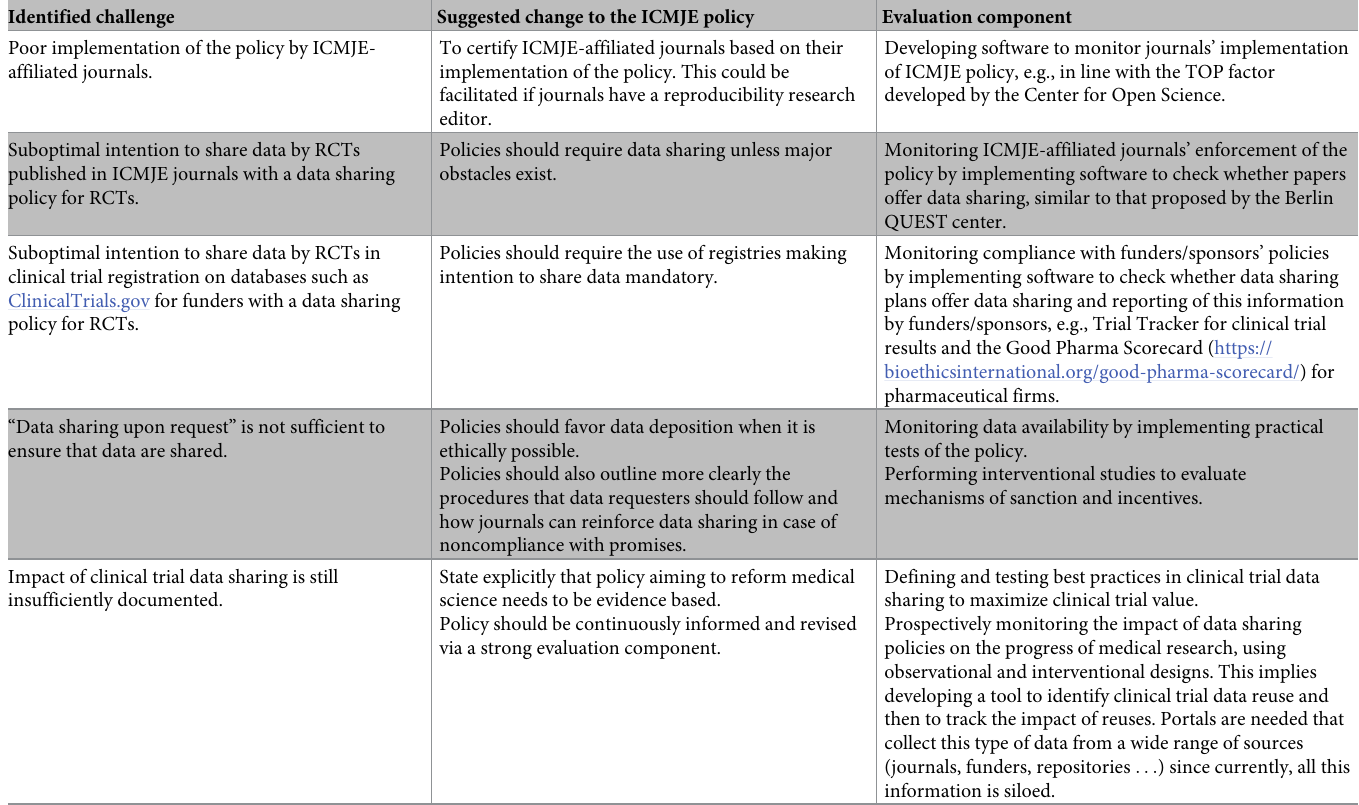
Table 1. Some identified challenges, suggestions, and evaluation components for the ICMJE data sharing policy. Identified